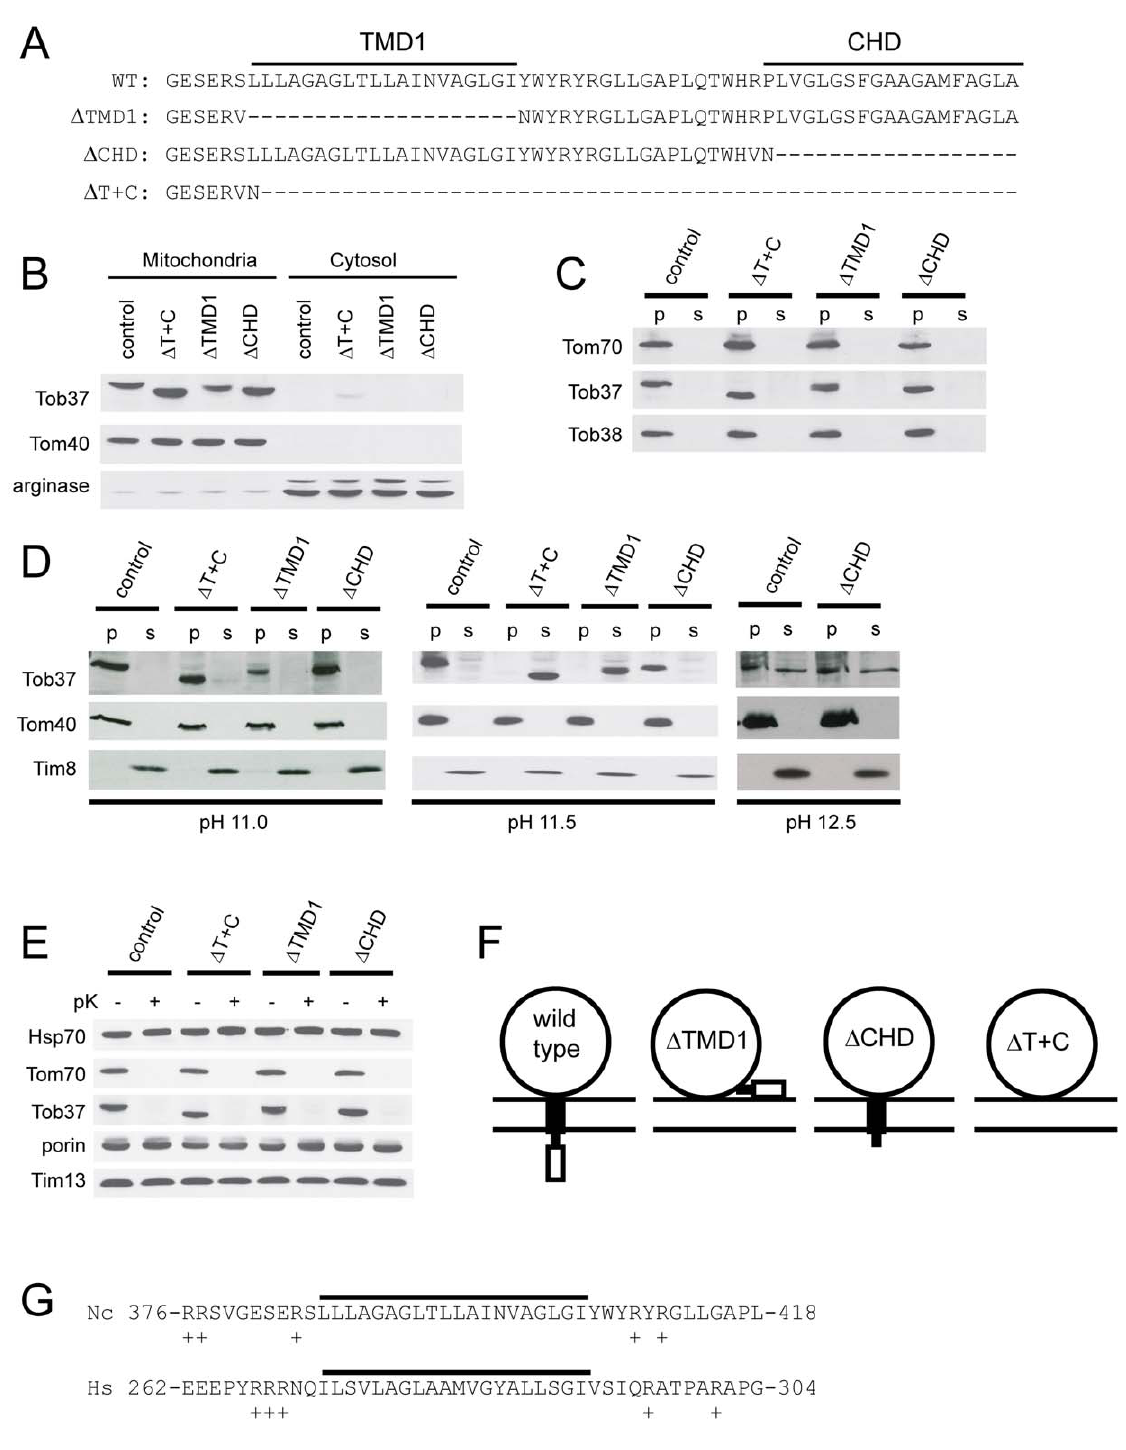
Figure 5. Role of predicted TMDs of Tob37. (a) The WT row shows the sequence of the 63 amino acids at the C-terminus of wild type N. crassa Tob37. D TMD1 is the deletion constructed for the first possible transmembrane domain and is the name of the strain expressing this form of Tob37. Similarly for CHD, the second possible TMD found at the C-terminus of the protein, and for D T + C, the deletion of the last 56 amino acids of the protein which removes both possible TMDs. (b) Mitochondria and post-mitochondrial supernatants (cytosol) were isolated from strains expressing the mutant forms of Tob37 described in panel A. Samples of each were subjected to SDS-PAGE and transferred to nitrocellulose. The membrane was immunodecorated with the antibodies indicated on the left. The control was strain 76-26. Arginase represents a cytosolically localized control protein that is synthesized from two different start codons of the same locus [67] so that two bands of 41 kDa and 36 kDa are observed. (c) As in panel A except isolated mitochondria were treated for 30 min on ice with isolation buffer containing 0.5 M NaCl. Following the incubation period, mitochondria were pelleted. The supernatant was collected and desalted. The mitochondria were washed in isolation buffer and pelleted. Pelleted mitochondria and the desalted supernatant were subjected to SDS-PAGE. Proteins were transferred to nitrocellulose and the membrane was probed with the antibodies indicated on the left. (d) Mitochondria from the strains indicated above the panel were subjected to alkali treatment using 0.1 M